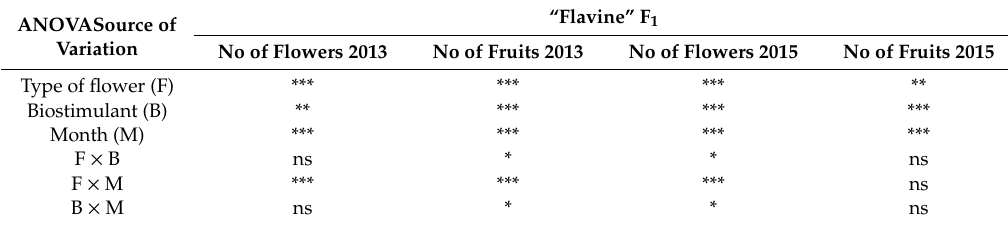
Figure 6. The course of flowering and fruit setting of “ Flavine ” F 1 eggplant as depended on fruit type and biostimulant treatment. C, control; B, biostimulant. Bars represent mean number of flowers per plant in 2013 ( a ), 2015 ( b ) and fruits per plant in 2013 ( c ), and 2015 ( d ) (error bars indicate SE). Table 4. Results of ANOVA for parameters of flowering and fruit setting of “Flavine” F 1 eggplant presented in Figure 6.